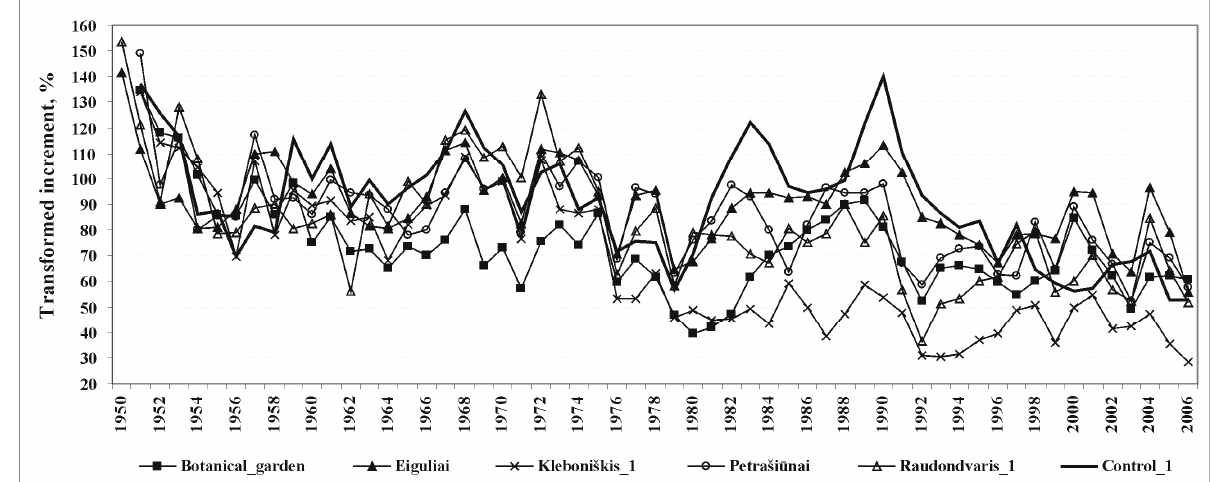
Fig. 2. Transformed dendroscales of 60 – 70 year old pines in Control_1 and Kaunas city sample plots